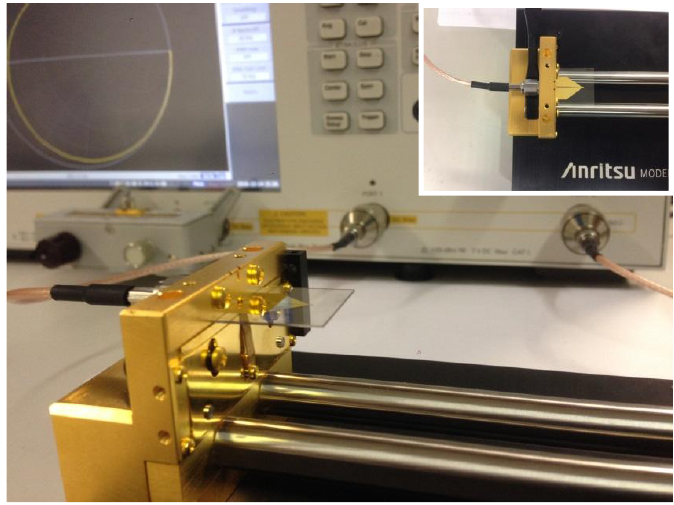
Figure 2. Photography of the test bench. The inset shows the top